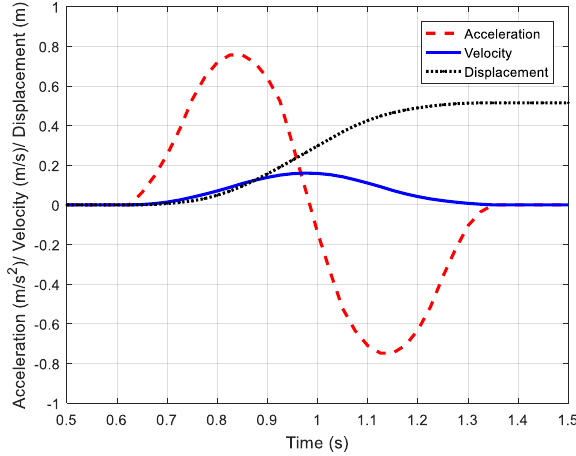
Figure 11. The acceleration, velocity, and displacement of one-step walking.